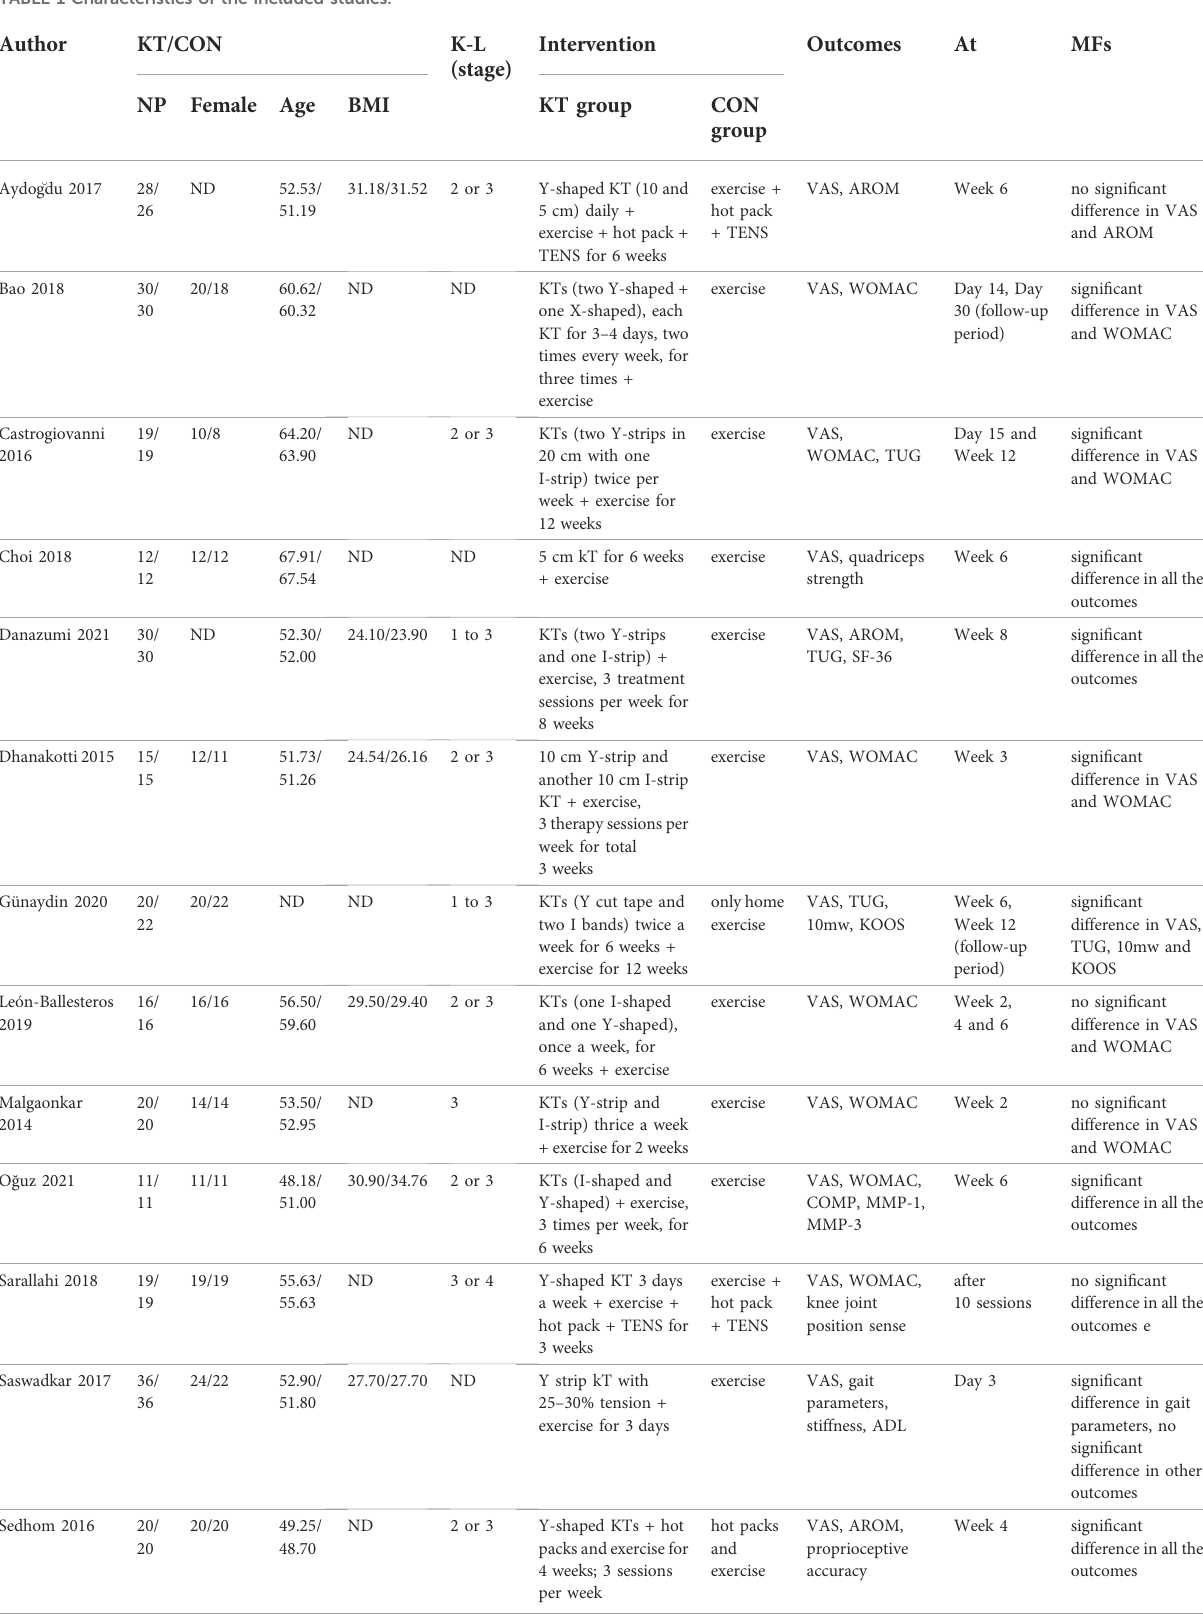
TABLE 1 Characteristics of the included